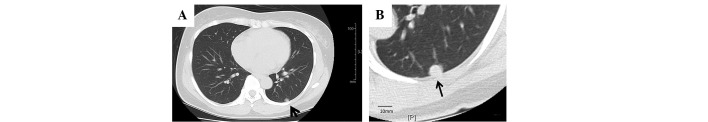
Computed tomography scan images of. (A) whole chest and (B) enlarged scan of the tumor.